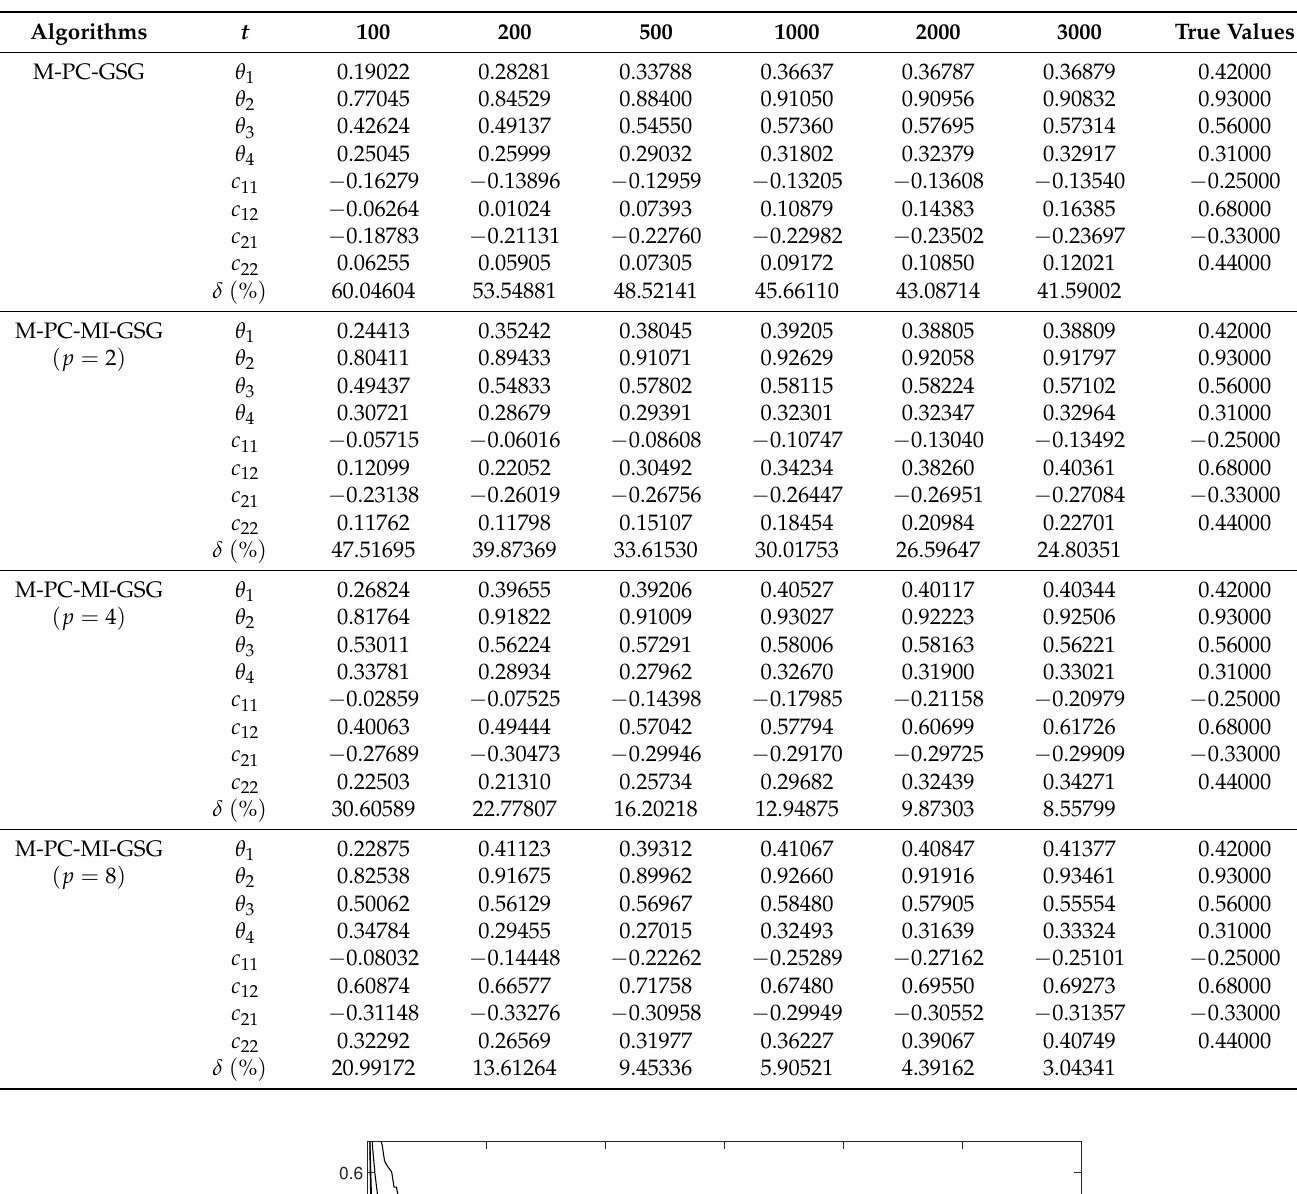
= 0.40 2 , σ 2 = 0.30 2 ). 2 1